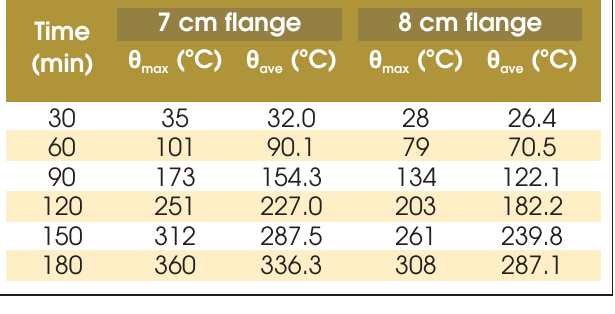
Figure 11 – Composite slab.